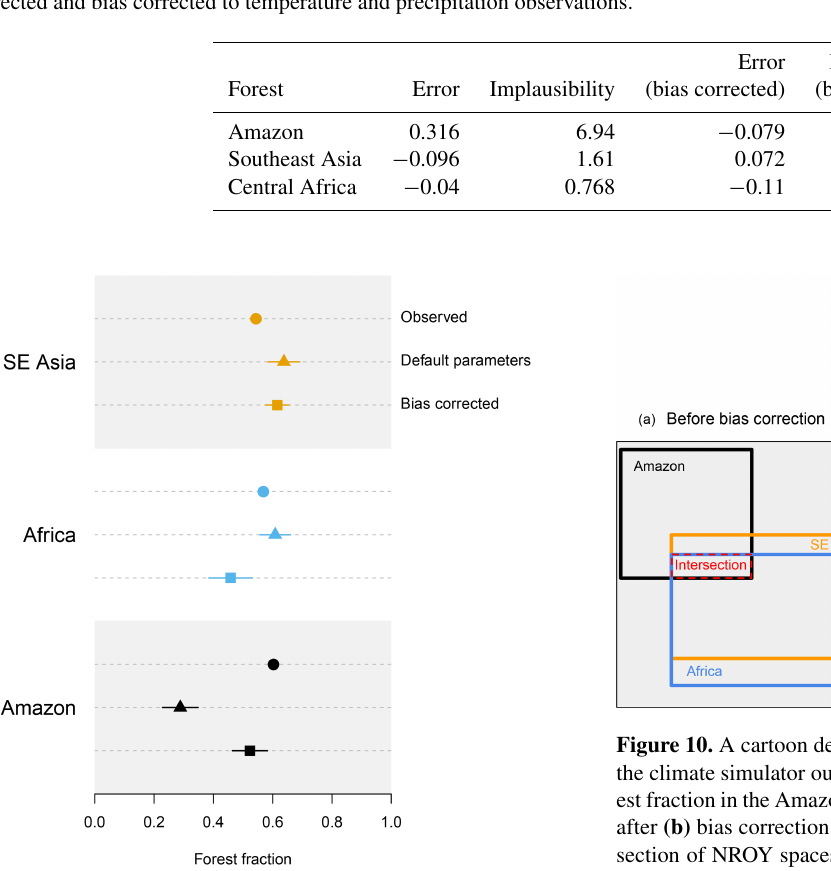
Table 2. Mean absolute error of the simulated forest fraction and implausibility of the default set of land surface parameters when not bias corrected and bias corrected to temperature and precipitation observations.